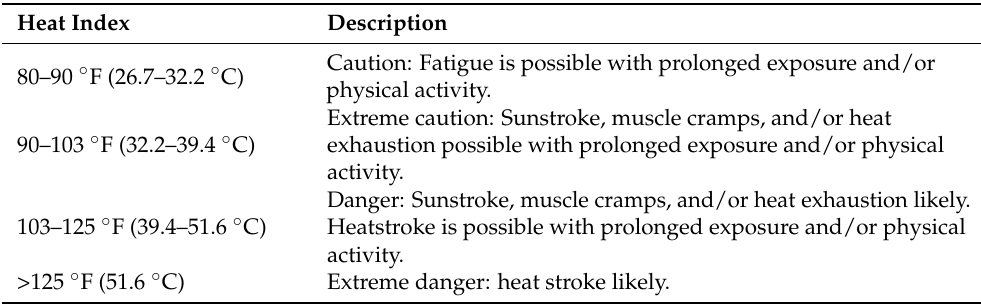
Table 1. Different levels of a heat index of health